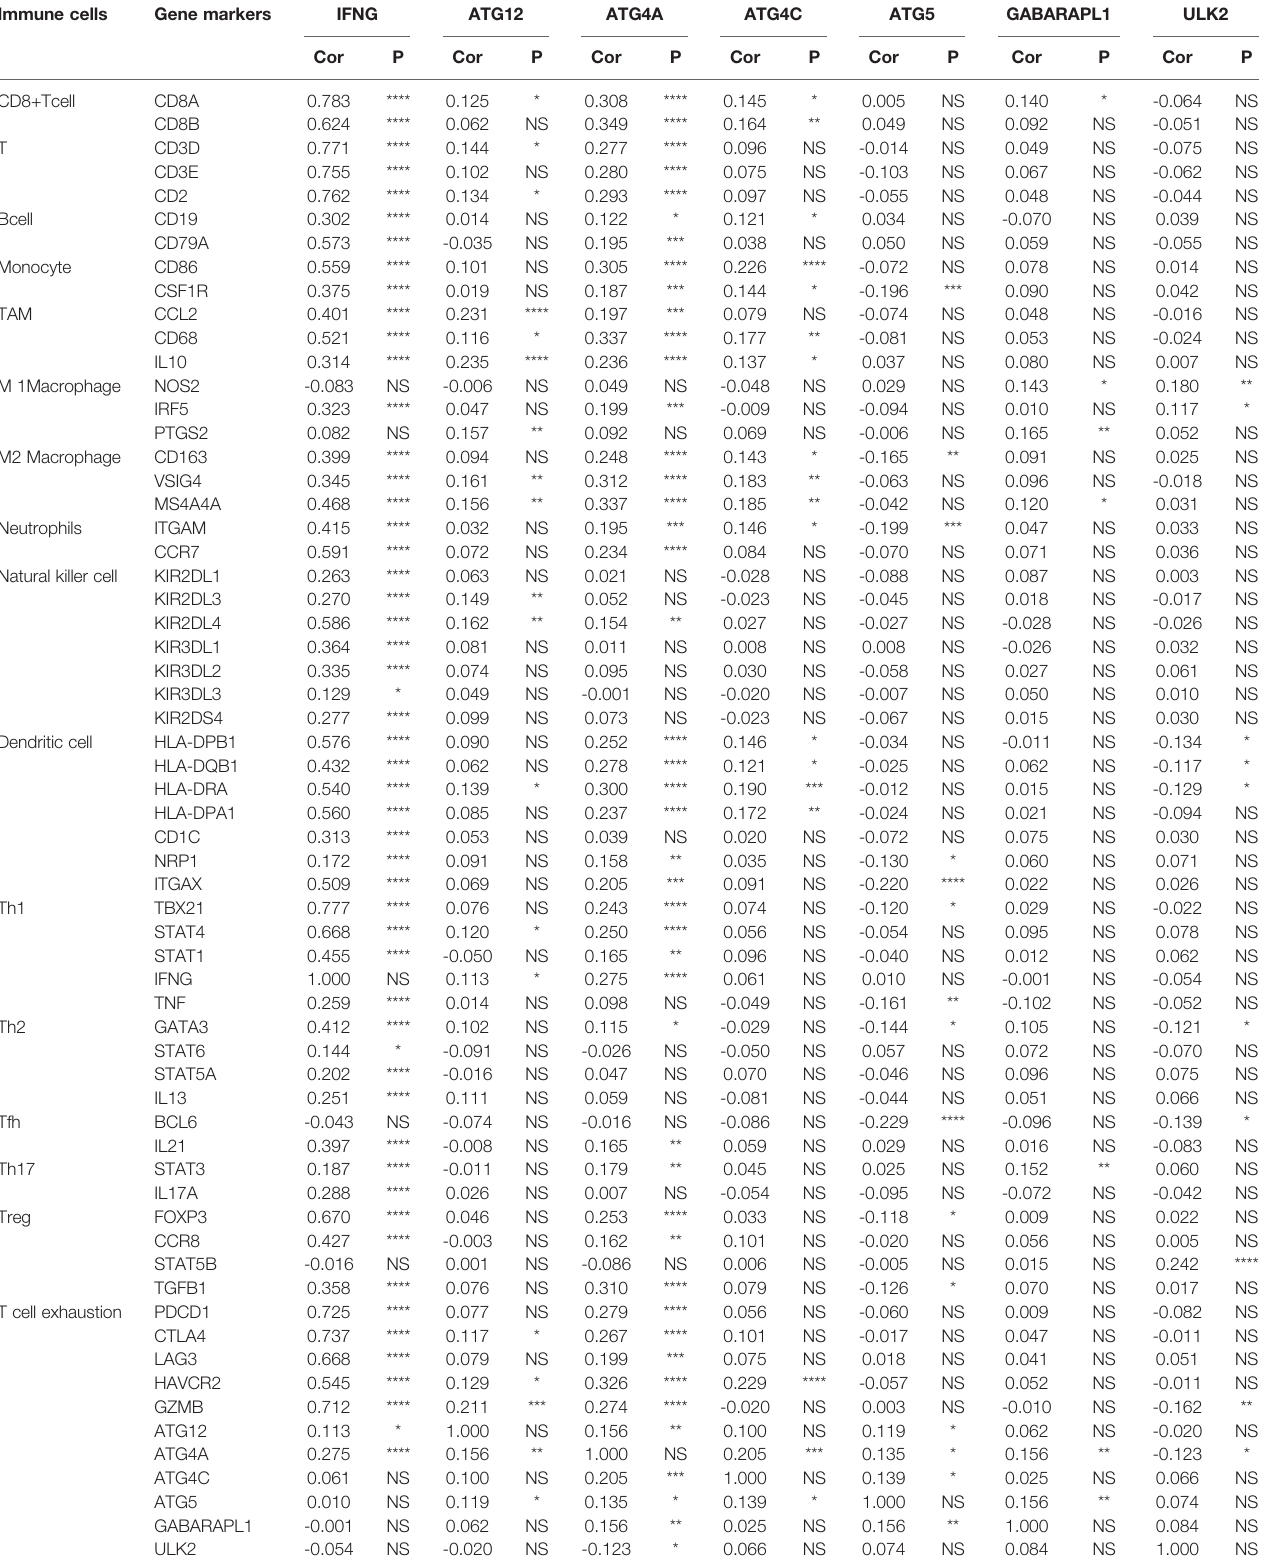
TABLE 3 | Correlation between 7 ARGs and immune cells. Immune cells Gene